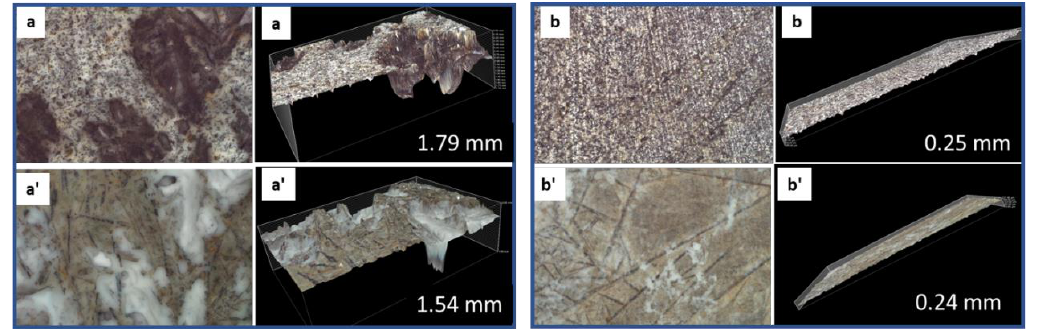
Figure 7. 3D images of anorthite before (top row: ( a , b )) and after (bottom row: ( a’ , b’ )) the acid exposure for two different sites. The numbers indicate the depth of the sample features on 3D images.